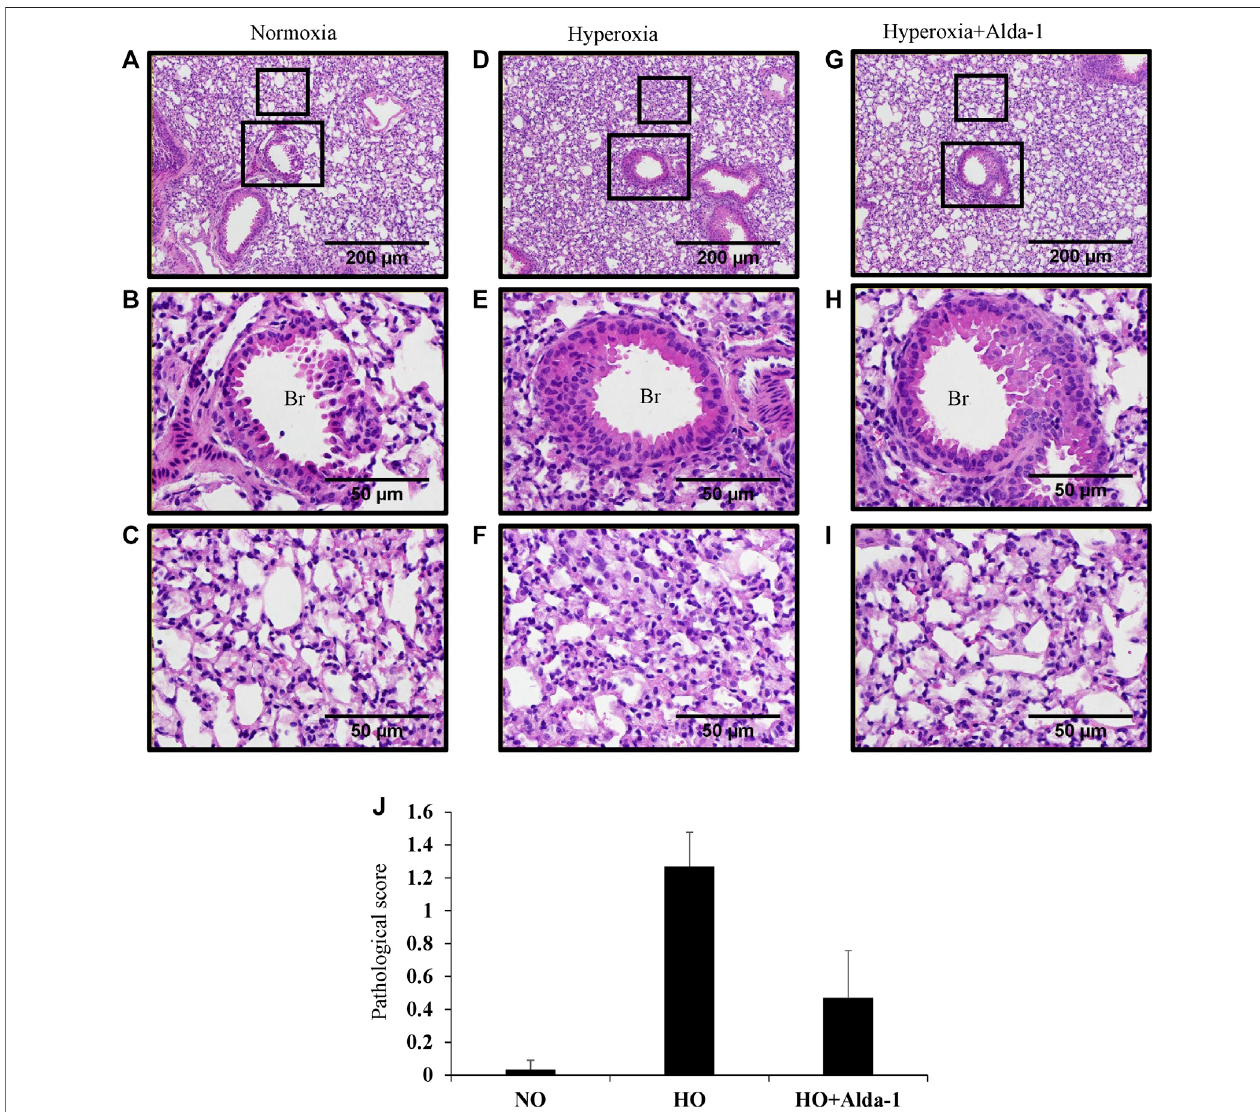
FIGURE2 | Alda-1 suppresses hyperoxia induced alveolar damage and lung in fl ammation: C57BL/6 mice were divided intothree groups: normoxia,hyperoxia, or hyperoxia + Alda-1. Representative photomicrographs ofthe H&E stained lungs derived from the three groups. Br: Bronchiolararea. Magni fi cation: × 100 and × 400 and scalebar:200and50 µm (A – I) .Histologicalchangesweregivenapathologicalscore (J) .RepresentativeH&Eimagesfromatleastthreemice/group.Dataareshownas means with SE or SD.